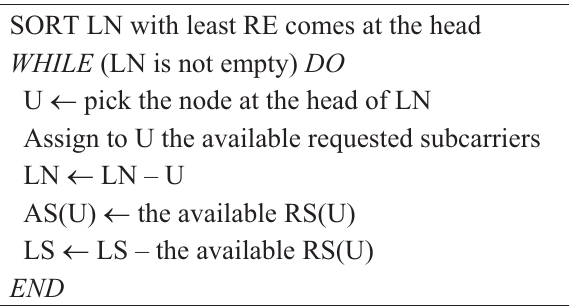
Table 3. Pseudo code for the energy conscious mode (ECM) of